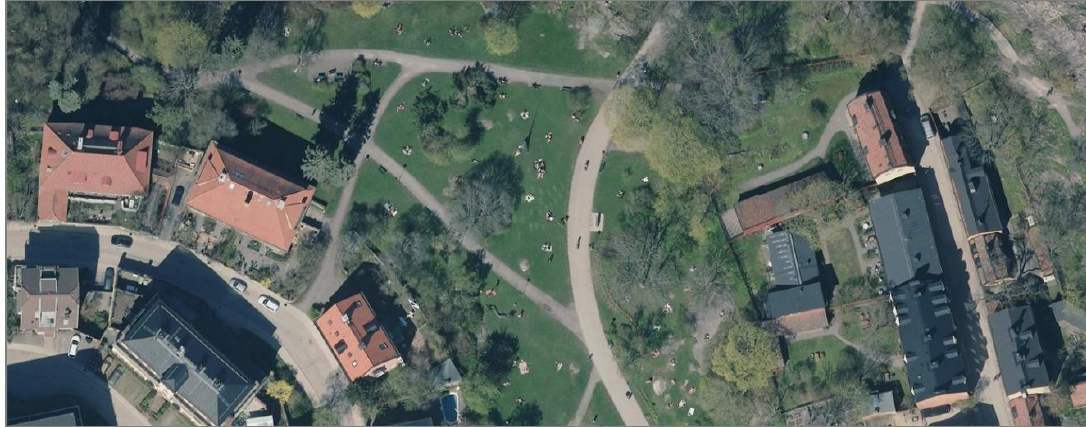
Figure 5 Inhabitation of Skinnarviksparken on a sunny summer day, showing the emergent results of a spatial negotiation of the surface as well as the degree of occupation. Aerial photo by Stockholms Stad (© Stockholms Stad